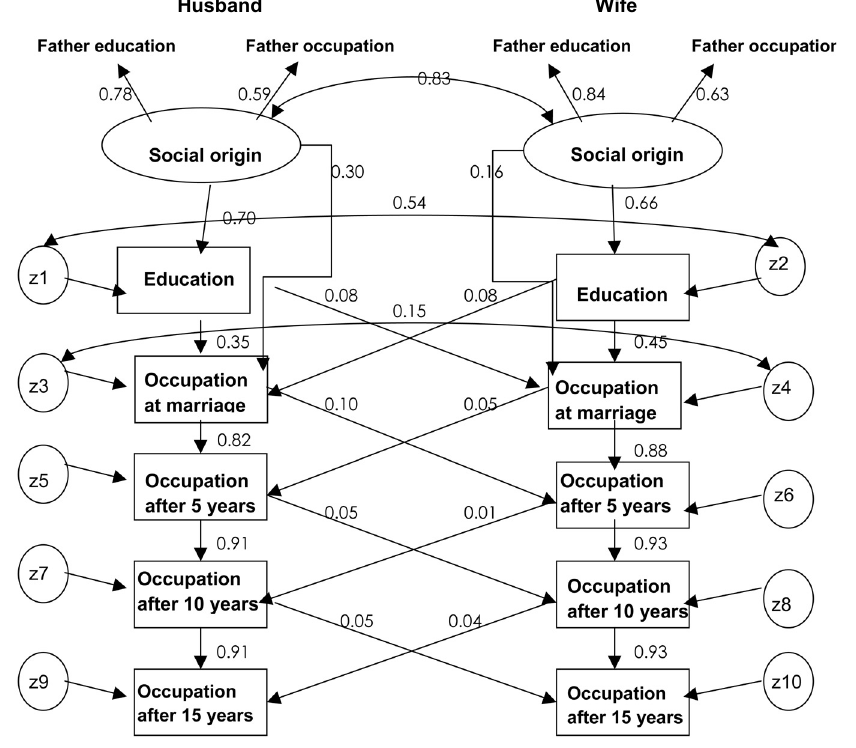
Reciprocal effects between husbands’ and wive’s work careers. Cross- lag model: standardised path